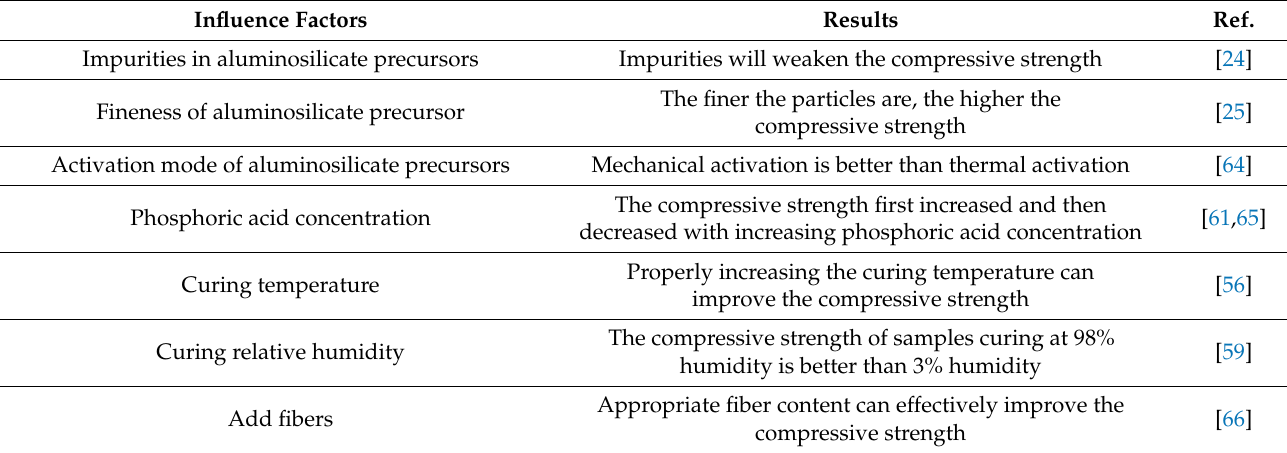
Table 2. Factors affecting the compressive strength of ASP geopolymers.